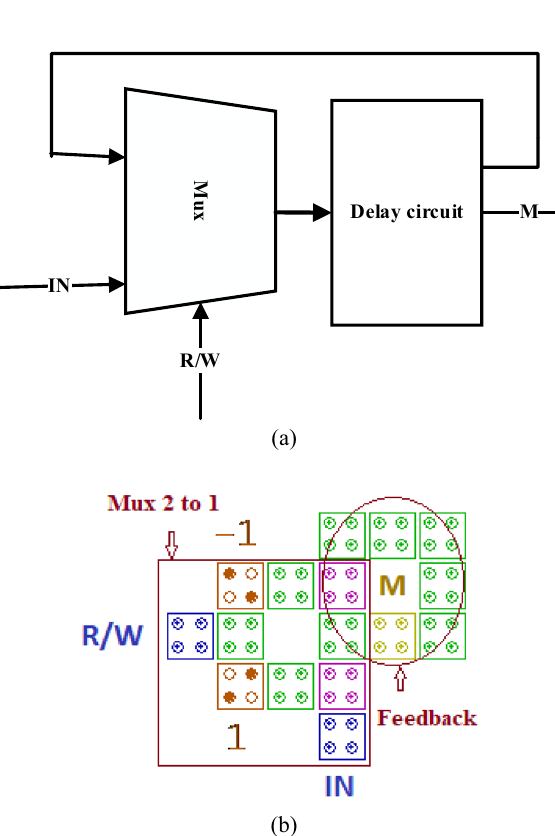
Fig. 13 The proposed memory unit; a block diagram and b imple- mentation in the QCA technology